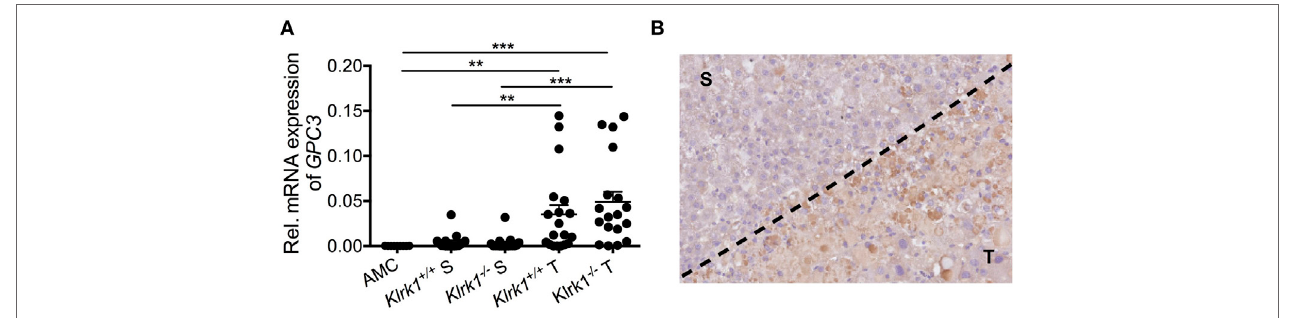
FiGUre 2 | Tumor-specific expression of glypican3 in hepatocellular carcinoma. (a) Quantification of Gpc3 mRNA transcripts within tumors (T) and surrounding liver tissue (S) in wildtype ( Klrk1 + / + ) and NKG2D-deficient ( Klrk1 − / − ) diethylnitrosamine (DEN)-treated mice ( n ≥ 17) and AMC ( n = 9). (B) Representative IHC staining of GPC3 on a DEN-treated liver where T represents the tumor area and S represents the surrounding tissue. Graph represents the mean ± SEM. Statistical analysis was performed by unpaired Student’s t test, where statistically significant differences between groups are denoted as: ** p ≤ 0.01 and *** p ≤